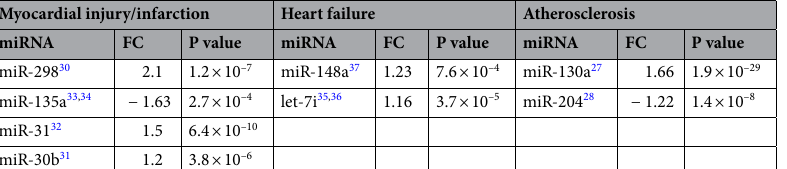
Myocardial injury/infarction Heart failure